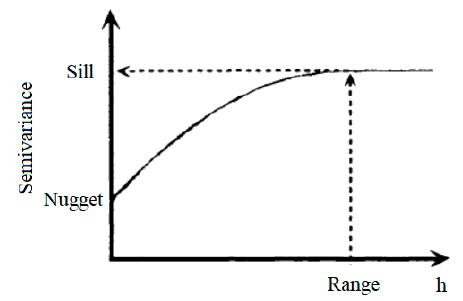
Figure 3. A variogram and its parameters [21].